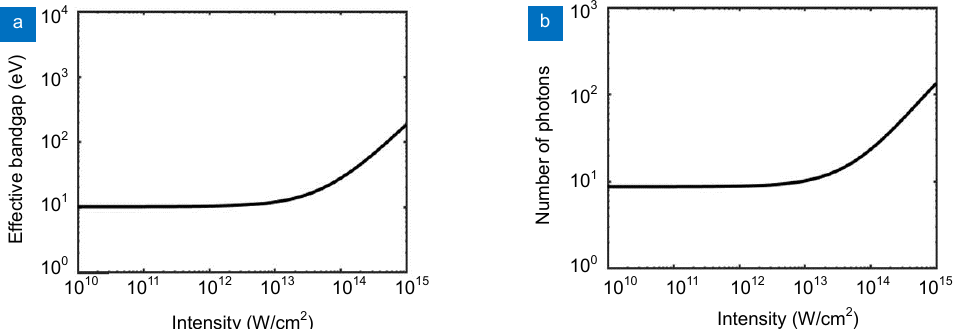
Fig. 4 | (a) Effective bandgap and (b) number of photons required for MPI process as a function of laser intensity in sapphire.